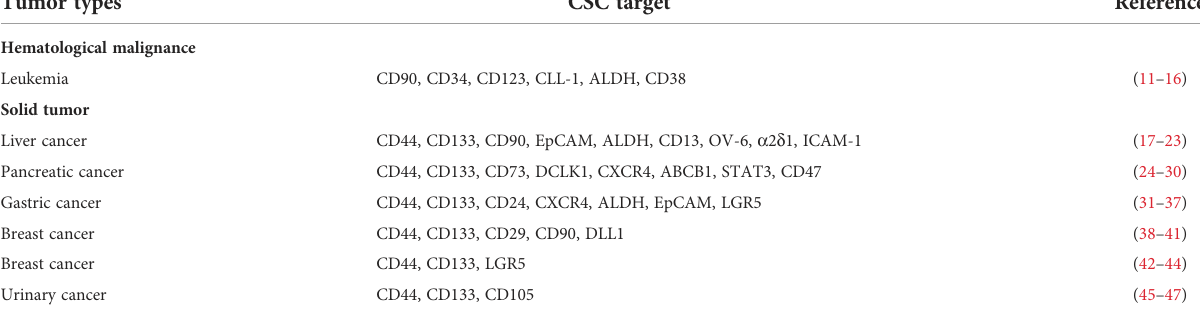
TABLE 1 CSC markers which have been used as therapeutic targets in different